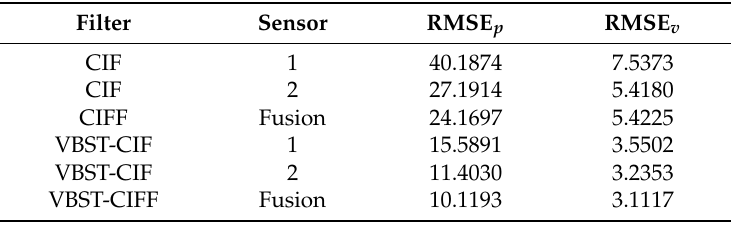
Table 2. MRMSEs in multi-sensor target